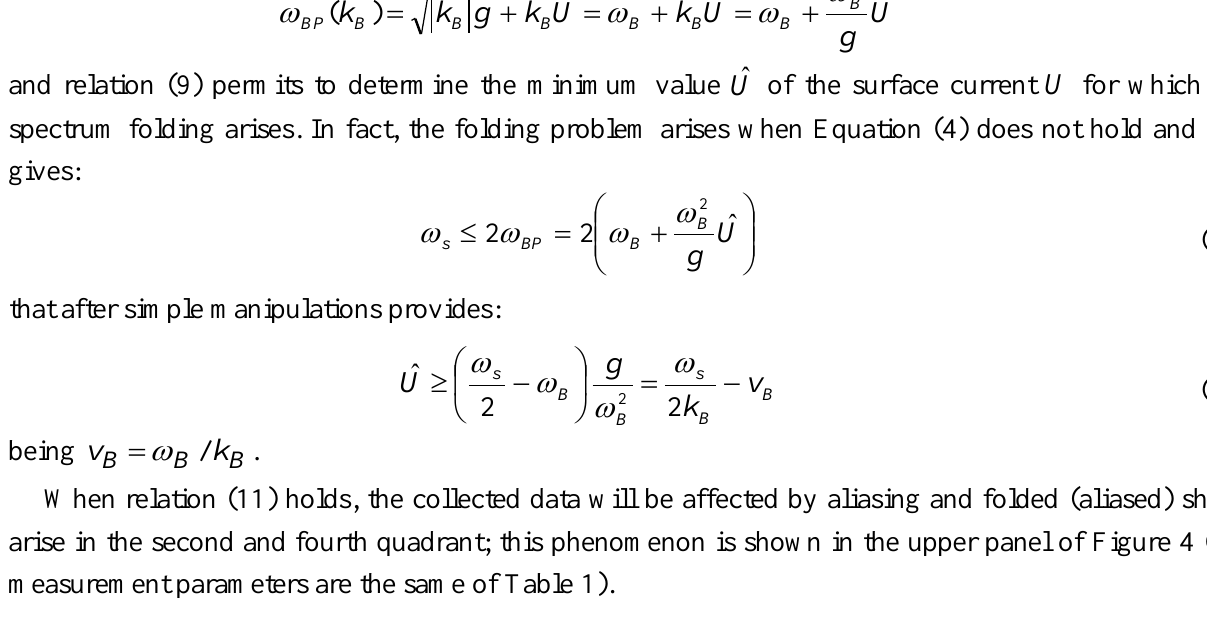
Figure 4. Upper panel : folded spectrum as Figure 2, referred to progressive waves, before of compensating the aliasing effect. Lower panel : Unfolded spectrum obtained by applying ~ the virtual current U of Equation (17) to the spectrum of the upper